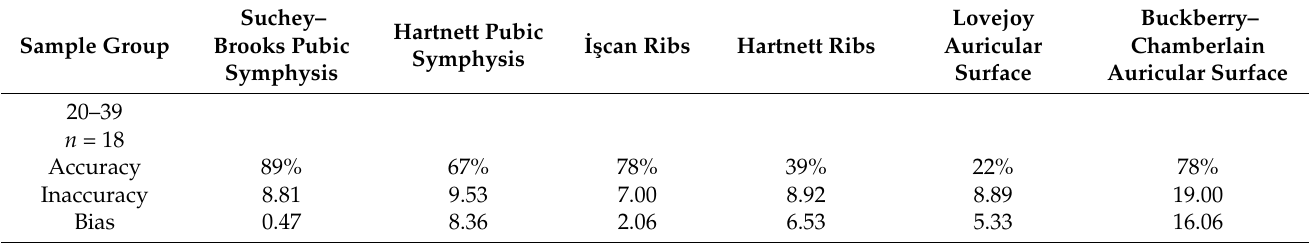
Table 5. Accuracy and reliability (inaccuracy and bias) of individual